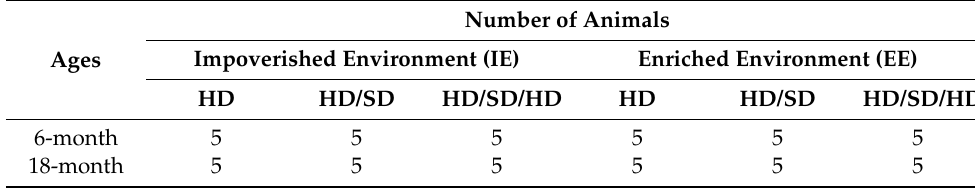
Table 3. Experimental groups and the distribution of the number of animals used in each group. Dis- tribution of the number of animals per diet regimen (HD, HD/SD, and HD/SD/HD), in impoverished (IE) and enriched (EE) environments, at the ages of 6- and 18-month-old. Number of Animals Impoverished Environment (IE) Enriched Environment (EE) Ages HD HD/SD HD/SD/HD HD HD/SD HD/SD/HD 6-month 5 5 5 5 5 5 18-month 5 5 5 5 5